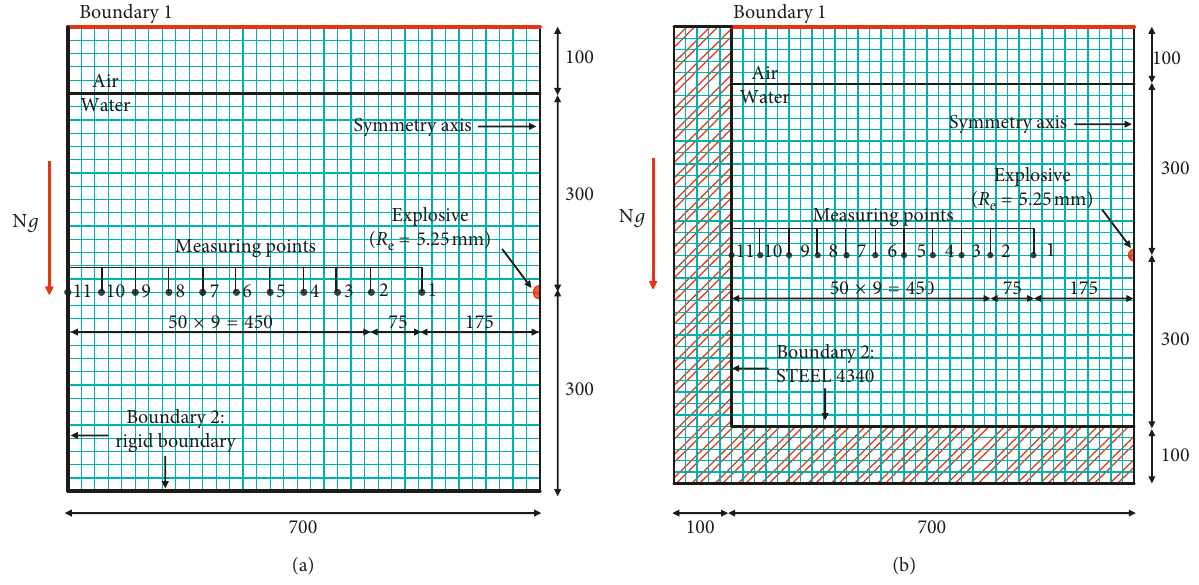
Figure 5: Two-dimensional numerical models of underwater